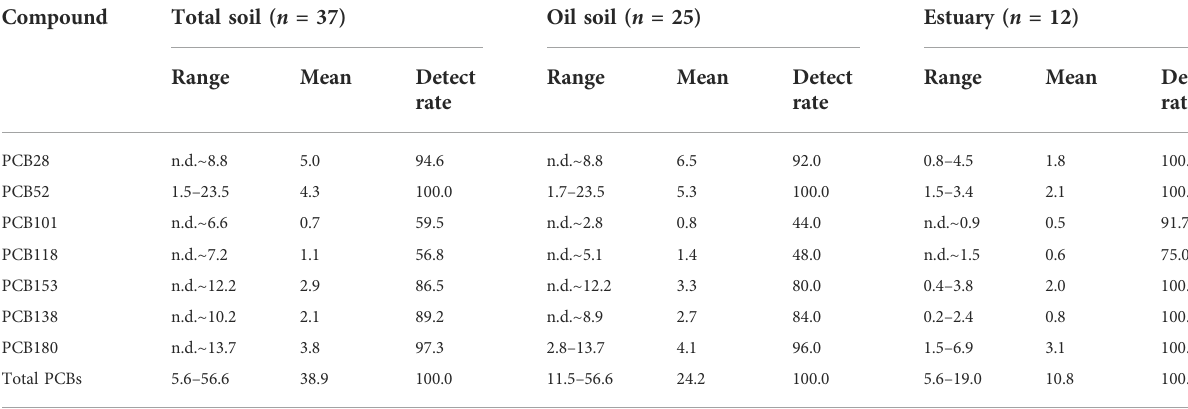
TABLE 4 The concentrations of PCB congeners ( μ g kg − 1 ) in different soil samples. Compound Total soil ( n = 37) Oil soil ( n = 25)